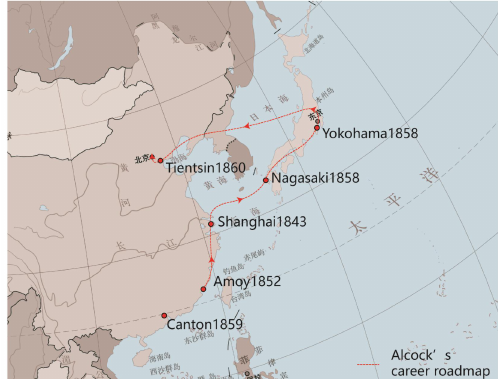
Figure 1 . The distribution of British concessions